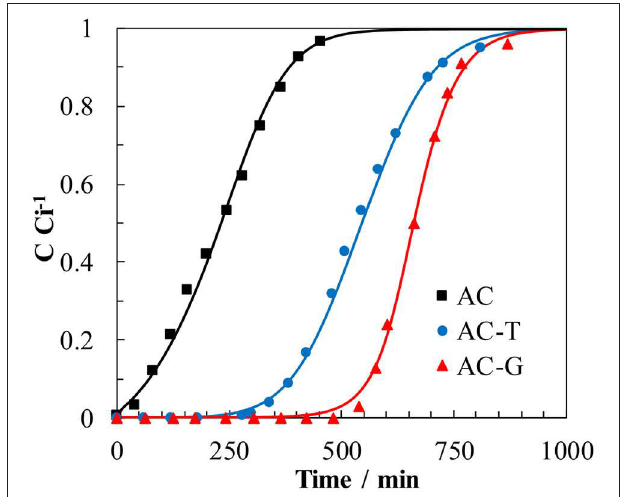
FIGURE 9 | Breakthrough curves in column operation for paracetamol adsorption on AC, AC-T, and AC-G (W: 200mg, Ci: 5mg L − 1 , T: 25 ◦ C; Q = 6mL min − 1 ). Dots: experimental data; lines: prediction from the solution of the mass balance.